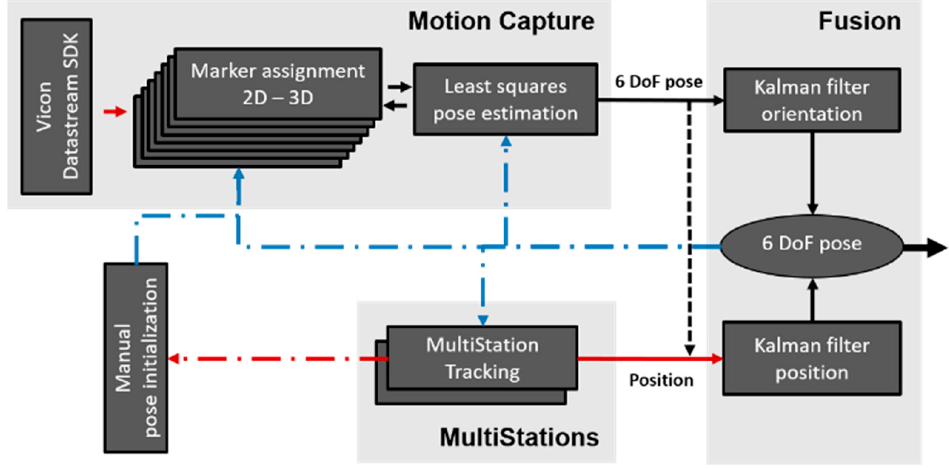
Figure 5. The core elements of the logical implementation. Each box represents one ROS node. The measurements are in red and the blue dashed–dotted arrows are pose messages that are needed as initial values.